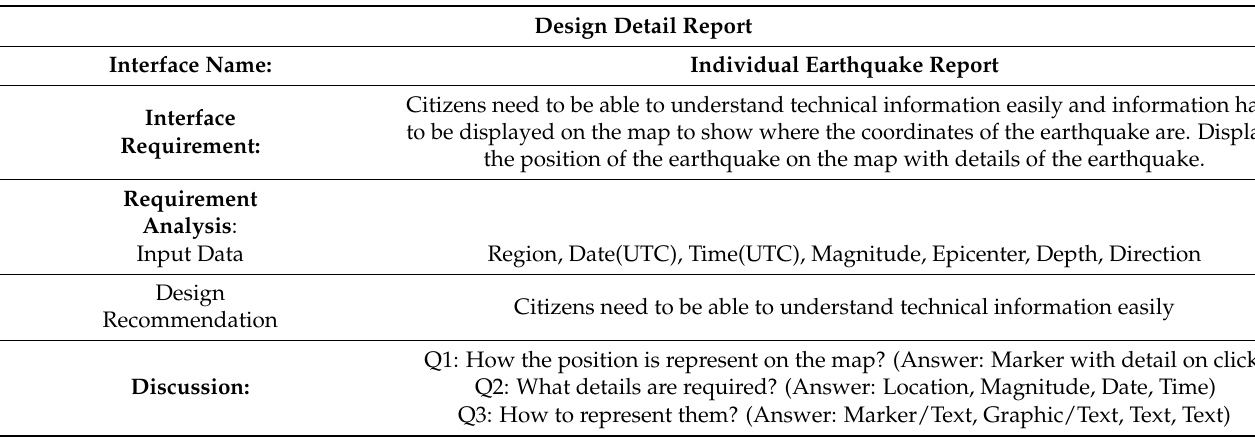
Table 3. Part one of the design detail report.